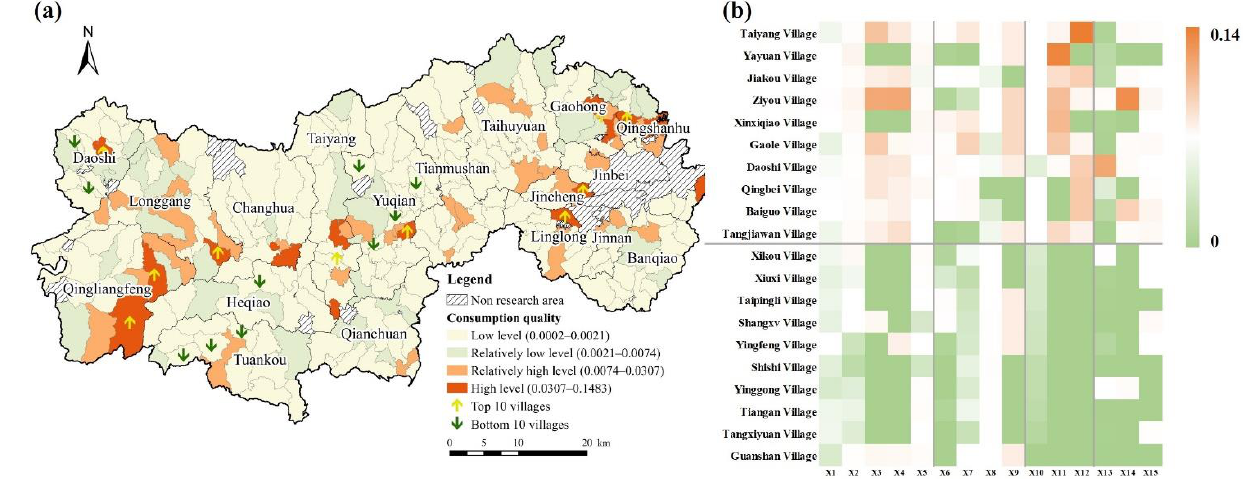
Figure 7. Performance of consumption quality in Lin’an District. ( a ) Consumption level index. ( b ) Top 10 villages and bottom 10 villages.